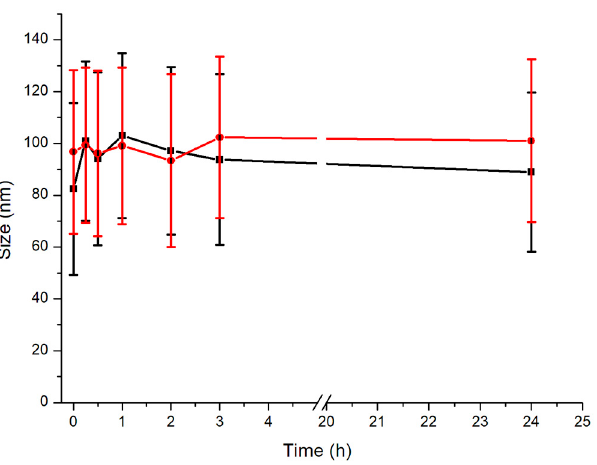
Figure 5. Colloidal stability study of MSN-3c in water ( ■ ) and in a biological media DMEM High glucose and FBS 50/50 ( ● ) at 1 mg mL − 1 .